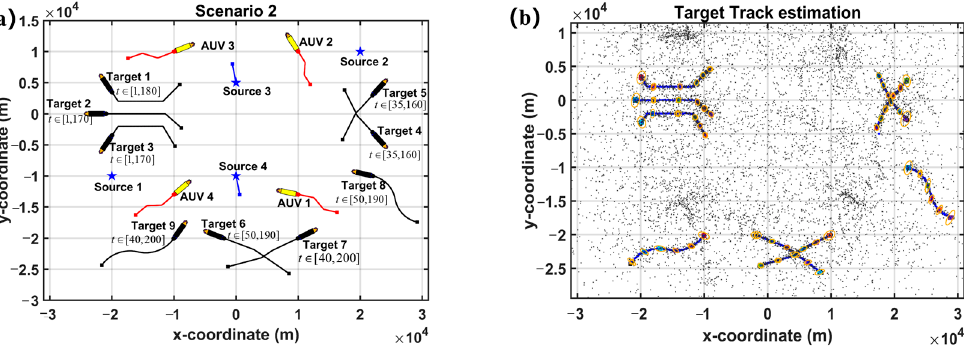
Figure 8. ( a ) Underwater multi-static MTT scenario two consists of four AUVs, two fi xed and two mobile sources, and nine targets. Solid lines represent the trajectories of AUVs, targets, and sources; ( b ) a superposition of the measurements (black dot) and the estimated target positions in one MC run. The ellipses are 99% error ellipses centered on the estimated positions of the targets every 40 time steps from the target start time.